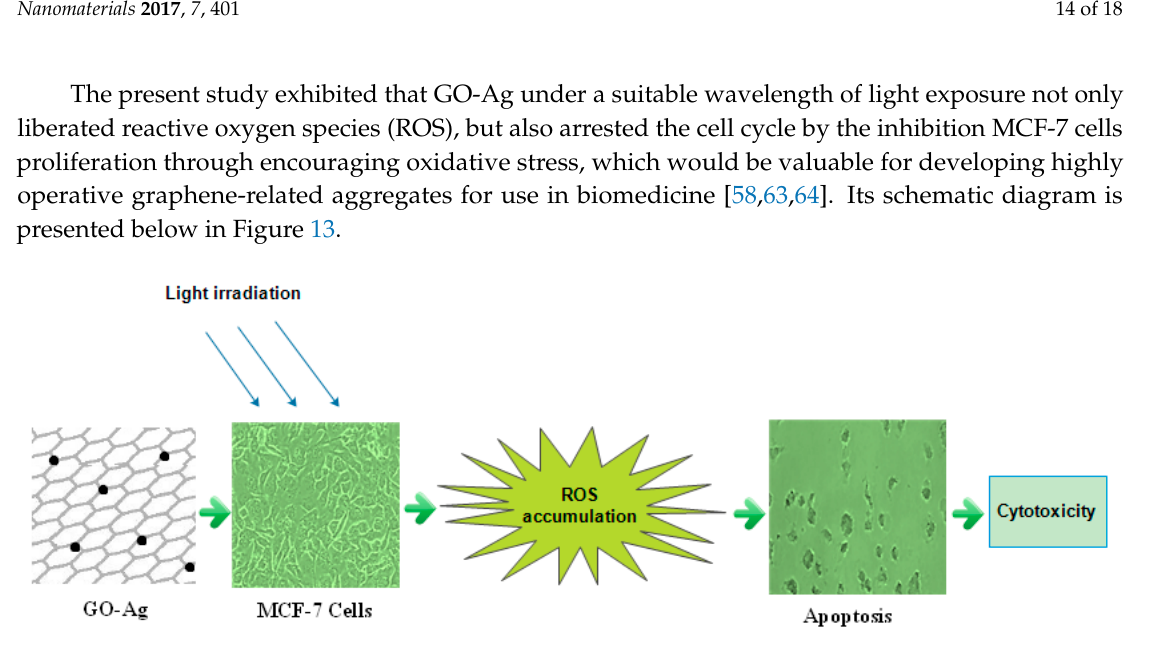
Figure 12. ( a ) ROS generation under light irradiation of suitable wavelength (430 nm), t -test ( * p < 0.05) ( b ) Linear calibration Plot of GO-Ag concentrationvs. ROS fluorescence under PDT (100 J/cm 2 ).